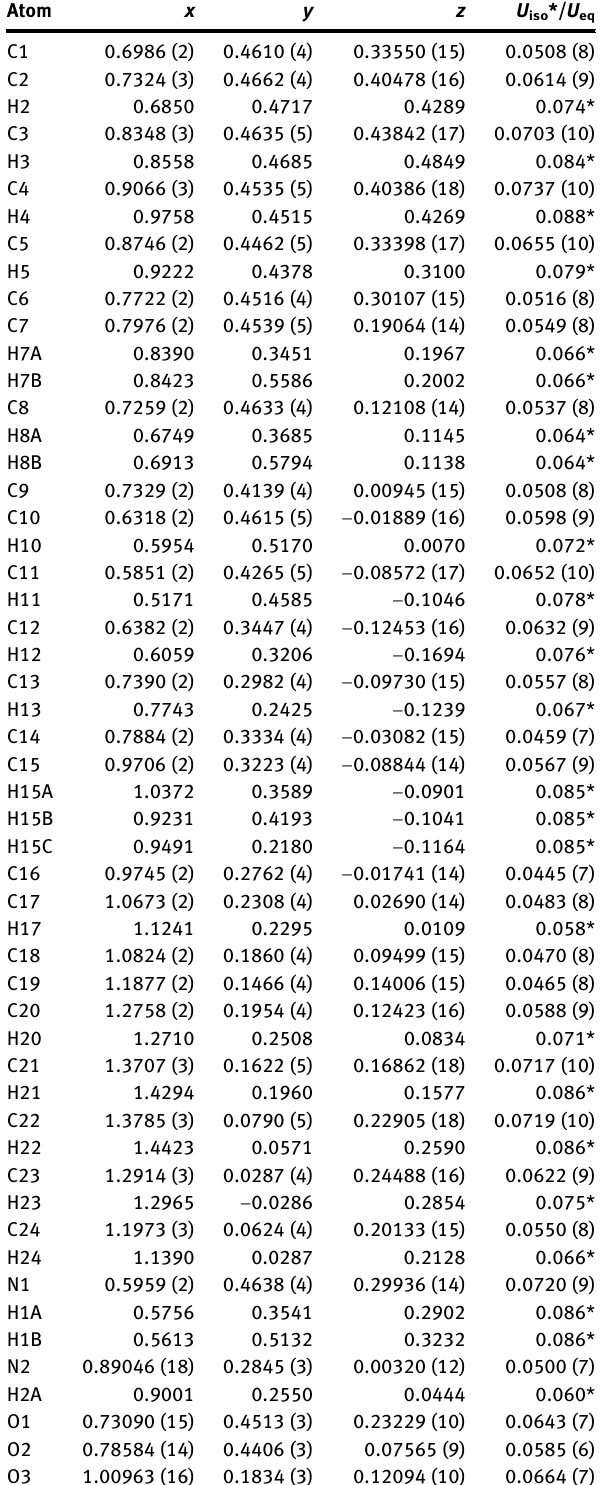
Table  : Fractional atomic coordinates and isotropic or equivalent isotropic displacement parameters (Å 